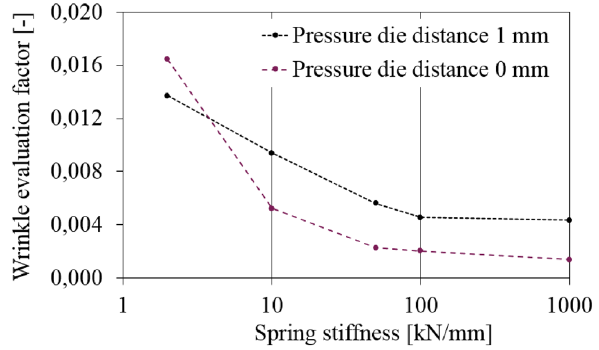
Fig. 11 Influence of axis stiffness on wrinkle formation in RDB